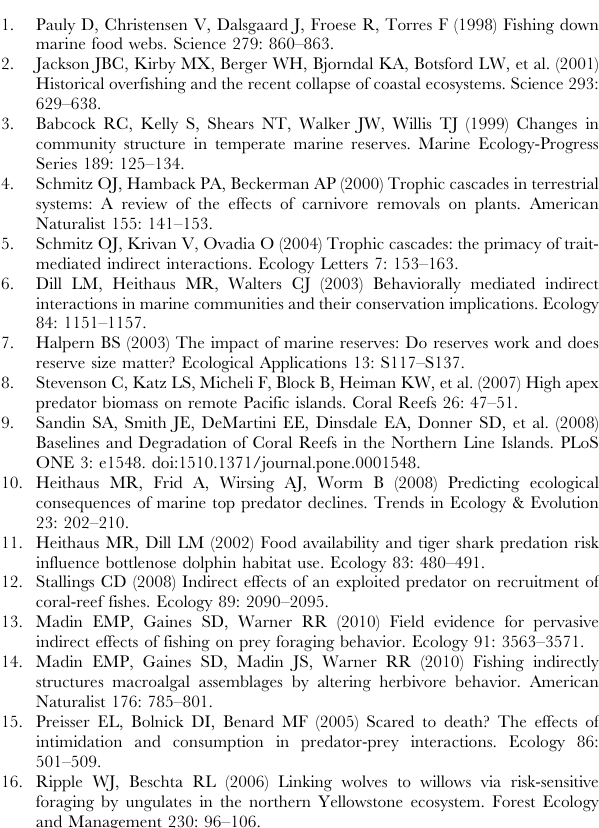
Figure S3 Density of competitors for focal species within Central Indo-Pacific reef pairs. Upper panel (a) is blackbar damselfish ( P. dickii ); lower panel (b) is bullethead parrotfish ( C. sordidus ). Bars are means ( 6